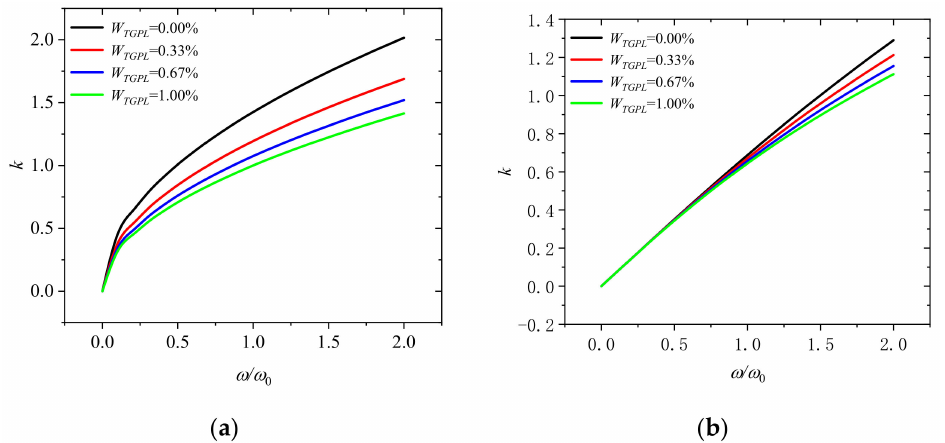
Figure 3. Wavenumber dispersion in rotating microbeam with different weight fraction of GPLs ( W TGPL = 0.00%, 0.33%, 0.67%, and 1.00%) for ( a ) Ω / Ω 0 = 0 and ( b ) Ω / Ω 0 =